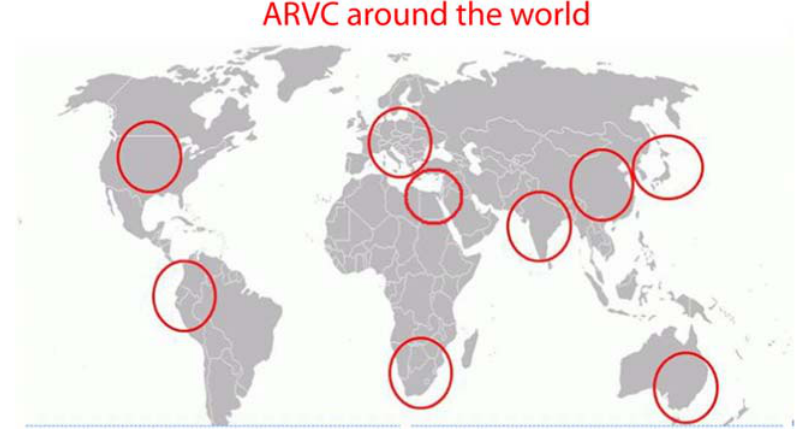
Figure 12. The global perspective of ARVC: ARVC has been reported and studied in Europe, Middle East, South Africa, India, China, Japan, Australia, North America and South America.